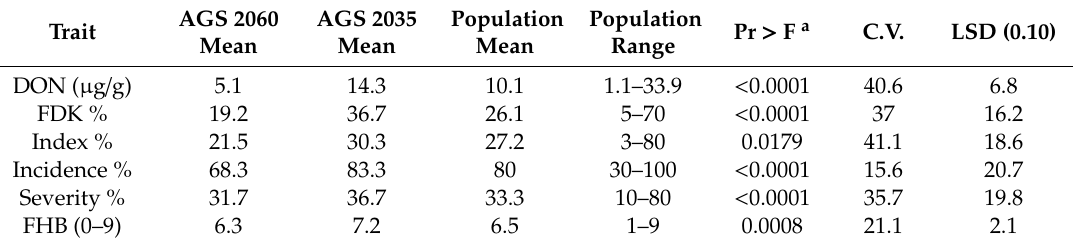
Table 1. Descriptive statistics for FHB resistance ratings of AGS 2060 x AGS 2035 DH population at Baton Rouge 2017.